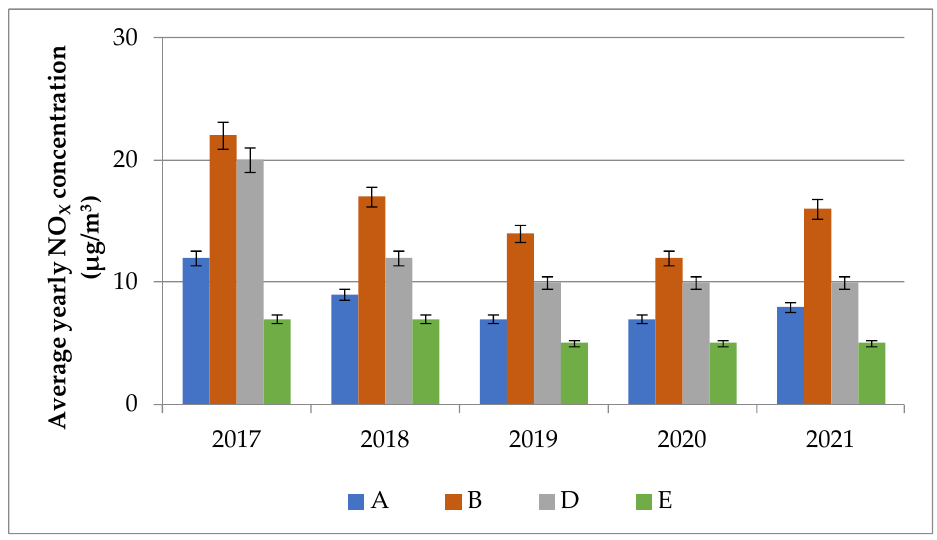
Figure 6. Average monthly NO X concentrations at locations A, B, D, and E between 2017 and 2021 (from left to right, from top to bottom).